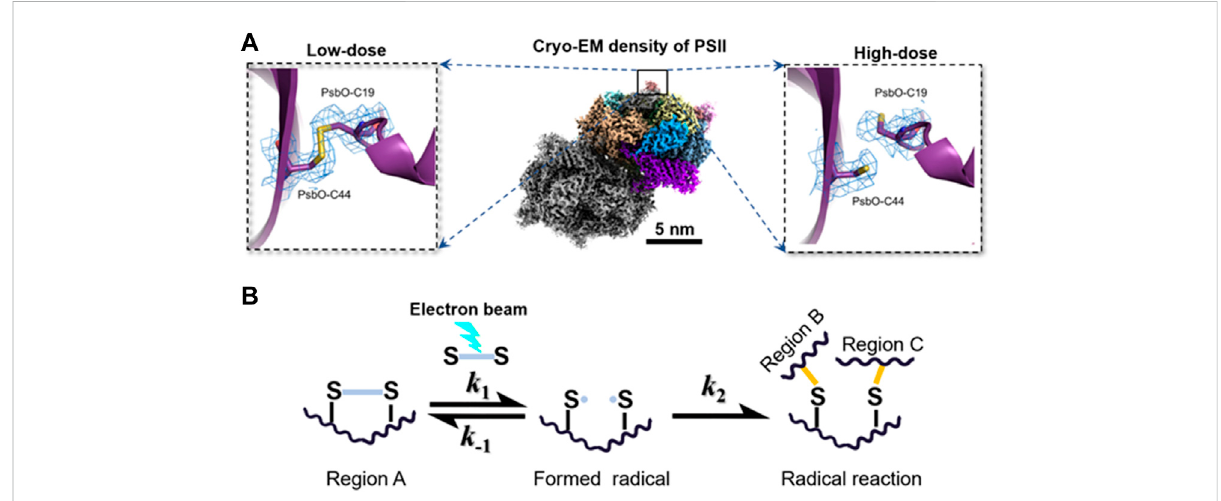
FIGURE 3 Electron beam – induced structural damages and radical reaction. (A) Broken disul fi de bond in PsbO of PII at high-dose (left) and the disul fi de bond recovered in PsbO of PII at the low-dose from single-particle averaging cryo-EM 3D reconstruction. Reproduced with permission (Kato et al., 2021). (B) Hypothetical scheme for radical reaction in the radiolysis damage. A radical reaction is initiated when an active site of disul fi de bond is converted into radicals under the electron beam. The formation of radicals is a reversible reaction, in which the radicals can react with each other to recover the original biomolecule with a reaction rate constant of k -1. Increasing k -1 can inhibit the radiation damage effectively. However, if theradical inregion A reactswithdifferentradicalsinother regions, theformation ofanew reaction productis generally irreversible.The permanent damage in the biomolecule usually misleads the subsequent 3D reconstruction and reduces the structural resolution. Reproduced with permission (Kato et al.,